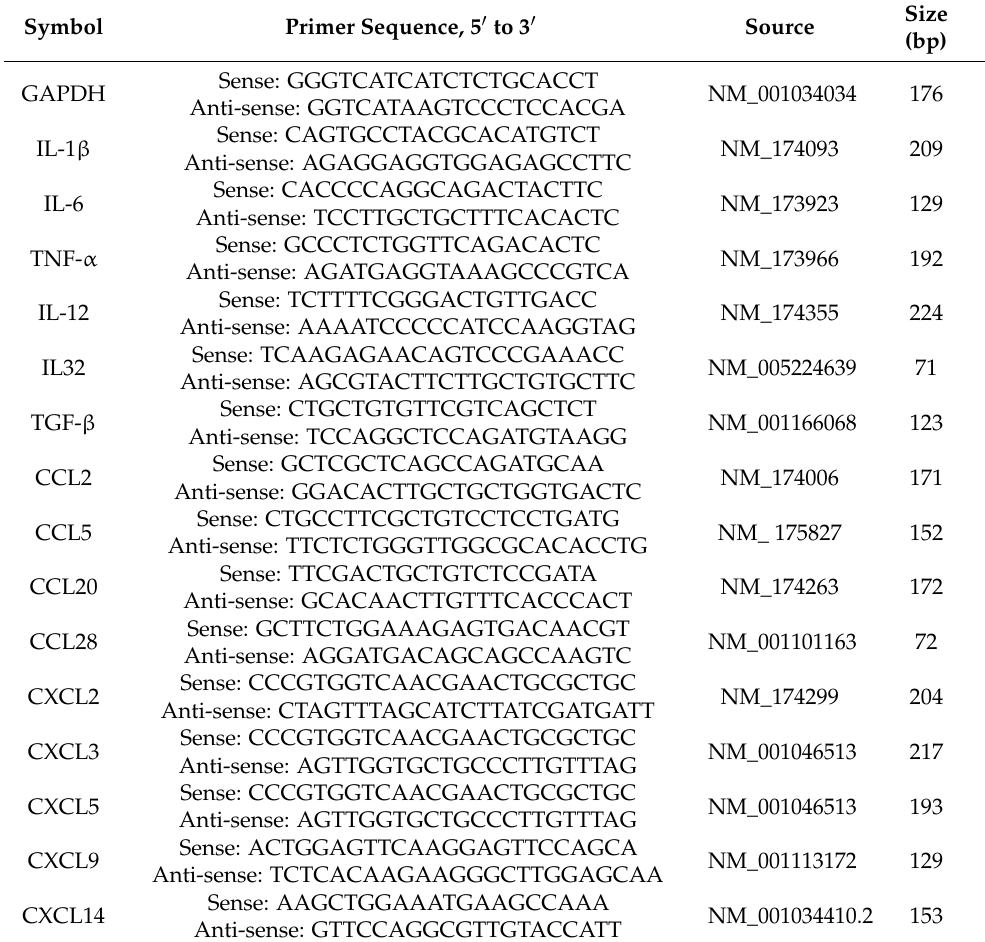
Table 2. Primers for reverse-transcription PCR (RT-PCR)